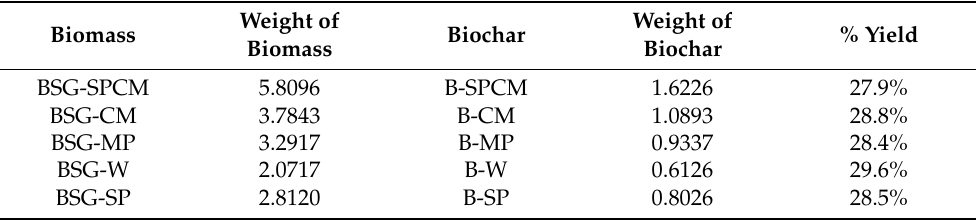
Table 1. Summary of the weight of biomass, biochar, and obtained % yield. Biomass